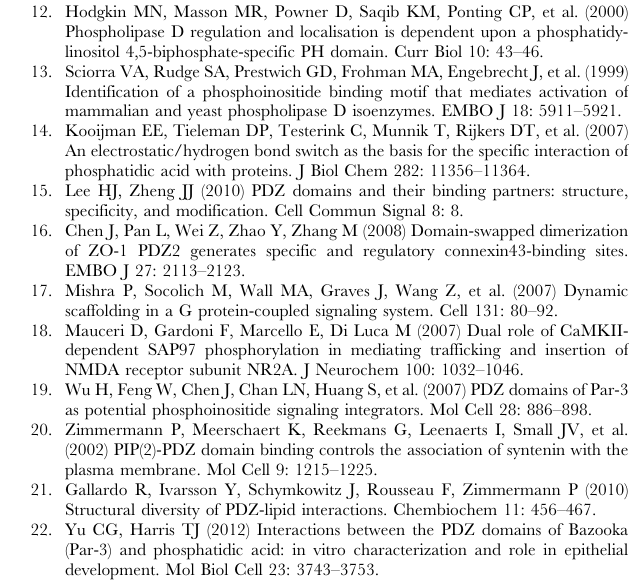
phosphatidic acid. A. In HEK293T cells PDZ domain of PDZGEF2 (CFP-PDZ2) localizes at vesicles in the presence of the PDZ domain of PDZGEF2 (CFP-PDZ2) to interact with PA show the percentage of cells showing vesicular localization of the protein in the presence of PIP5K a (9/12 cells for CFP-PDZ2 and 3/11 cells for CFP-PDZ2 in presence of CAY10593). All